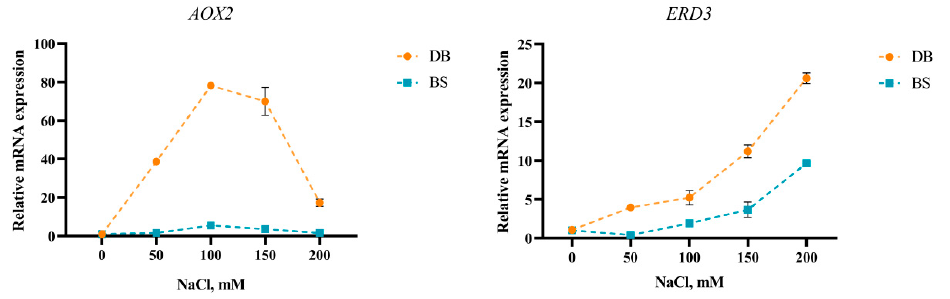
Figure 6. Effect of different NaCl concentrations on the expression levels of AOX2 and ERD3 of H. syriacus ‘Duede Brabaul’ (DB) and H. syriacus ‘Blueberry Smoothie’ (BS).